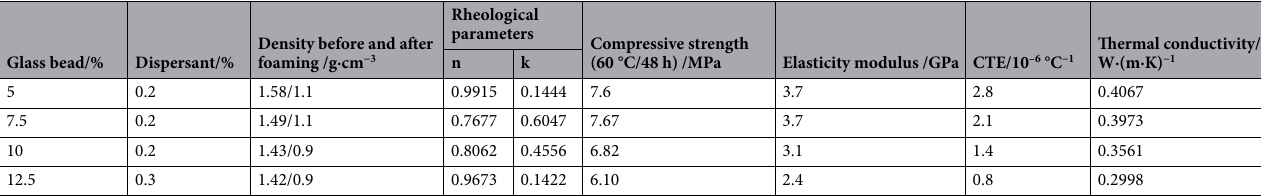
Table 3. Effect on the properties of cement.